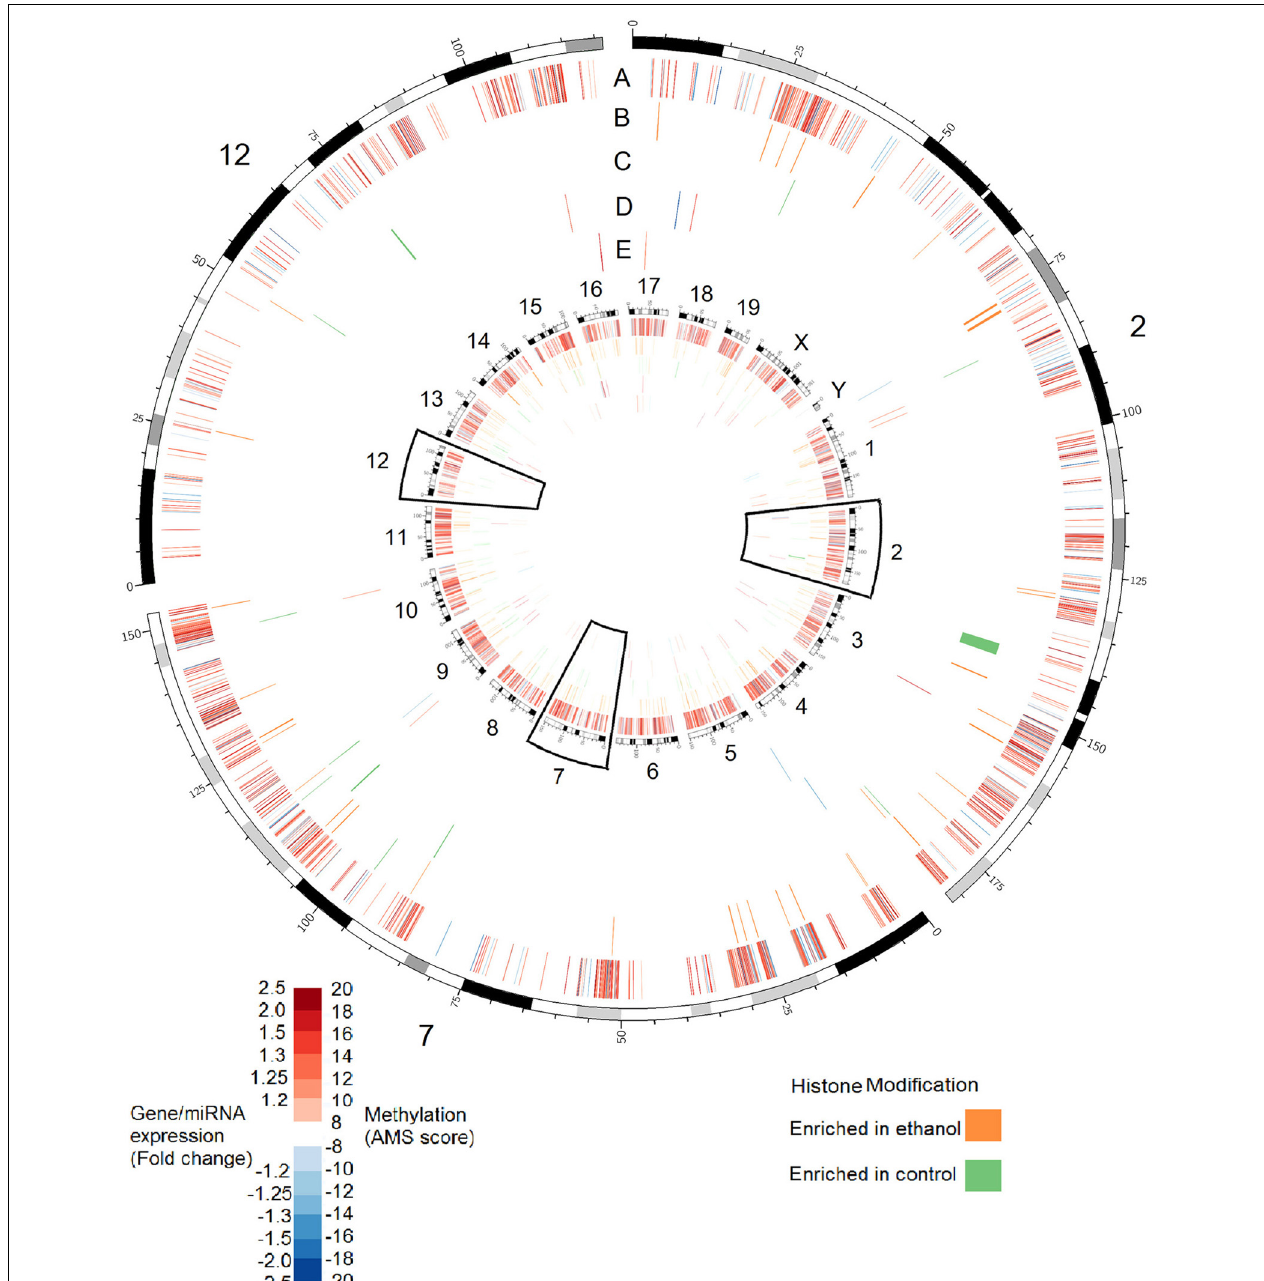
FIGURE 1 | Alterations in DNA methylation, histone modifications, miRNA expression, and gene expression in the hippocampus of adult (PD 60) mice exposed to ethanol during the trimester three equivalent (PD 7). Tracks show alterations in: (A) DNA methylation as measured by absolute methylation score (AMS); (B) Histone H3 lysine 27 trimethylation; (C) Histone H3 lysine 4 trimethylation; (D) miRNA